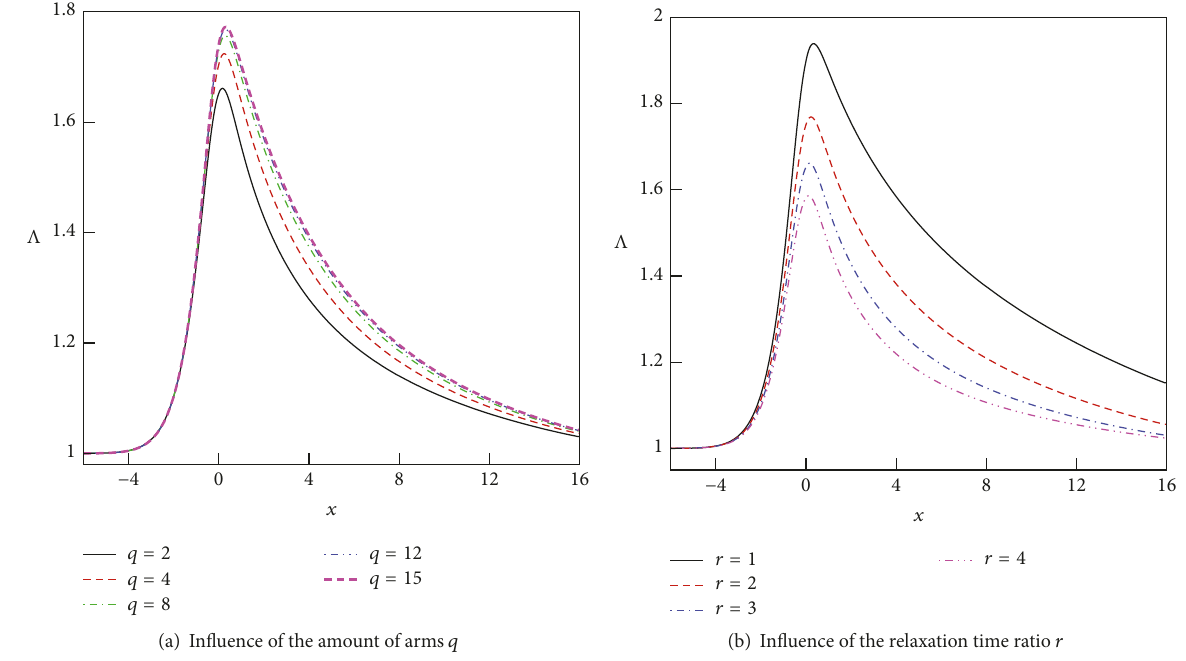
Figure 8: The influence of different parameters on backbone stretch (Λ) : (a) 𝑞 and (b) 𝑟